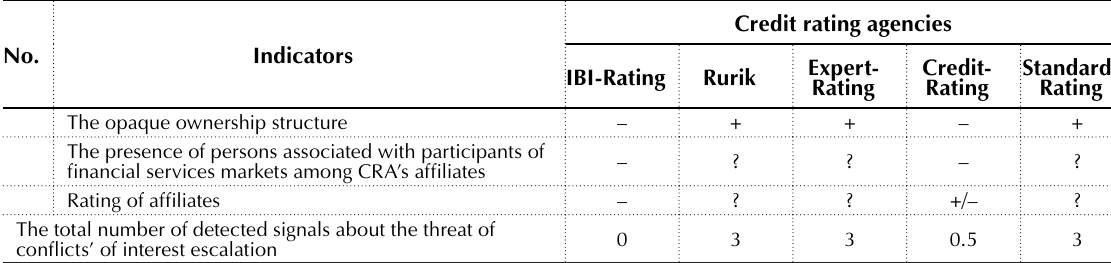
Table 1. The warning signals concerning the potential of conflicts of interest in models of ownership of CRAs in Ukraine No.